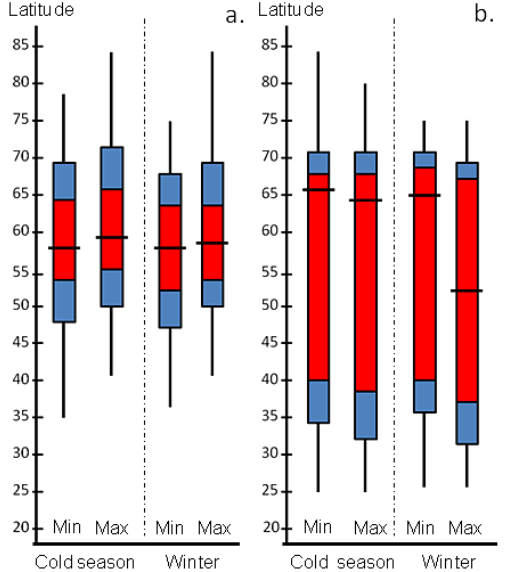
Figure 6. Cumulative latitudinal position frequency of minimum SLP (a) and maximum SLP (b) for different solar activity condi- tions (horizontal line, mean position; red box – frequency between first and third quartile; blue box – frequency between first and last decile; whiskers – appearance).